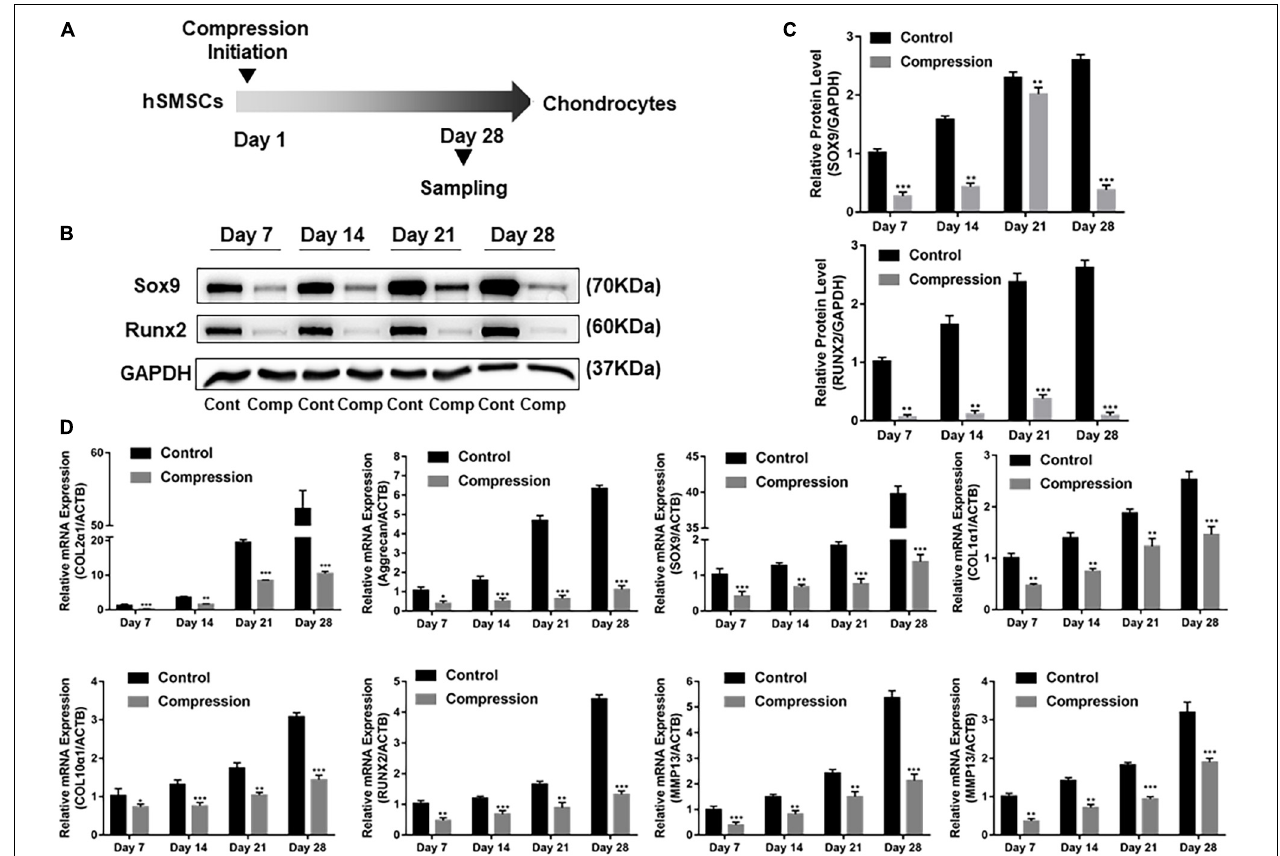
FIGURE 3 | Dynamic compression without preculture inhibited both chondrogenesis and hypertrophy of SMSCs. (A) Schematic of the experimental protocol. (B) Western blot analysis of expression level of SOX9 and RUNX2 at days 7, 14, 21, and 28. (C) Expression level of SOX9 and RUNX2 was shown in the histograms normalized with GAPDH. (D) Gene expression of chondrogenesis and hypertrophy development. Results are presented as the mean ± S.D. * P < 0.05, ** P < 0.01, *** p < 0.001. COL2 α 1, collagen type II; SOX9, SRY-box transcription factor 9; COL1 α 1, collagen type I; COL10 α 1, collagen type X; RUNX2, RUNX family transcription factor 2; MMP13, metalloproteinases 13; ALP, alkaline